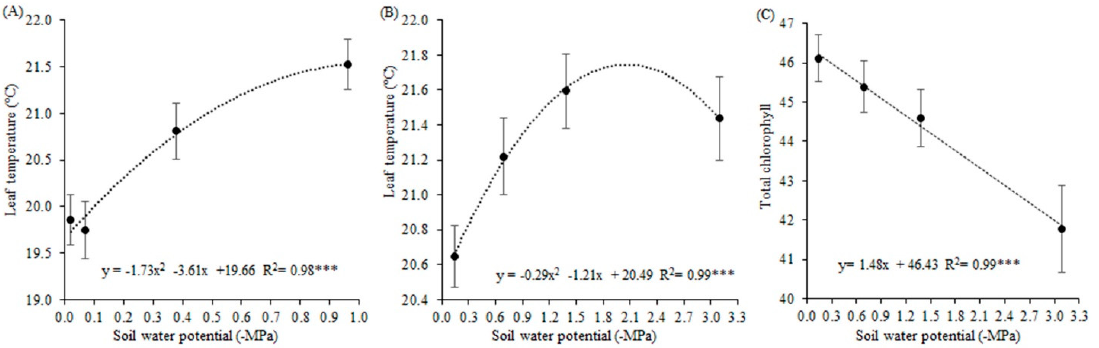
Figure 2. Leaf temperature in the first experiment ( A ) and the second experiment ( B ); Total chlorophyll ( C ) of soybean plants under different soil water potentials and xenobiotic and antioxidant agent applications. Note: asterisks indicate error probability as * = 10%, ** = 5%, and *** = 1%, respectively. Vertical bars represent the standard error of the